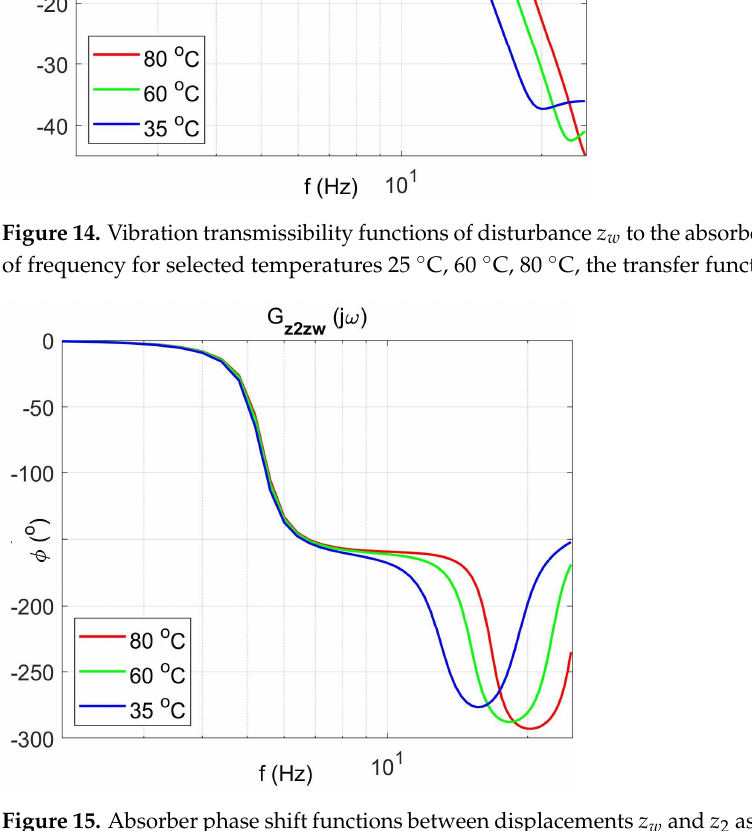
Figure 15. Absorber phase shift functions between displacements z w and z 2 as a function of frequency for selected temperatures 25 ◦ C, 60 ◦ C, 80 ◦ C, the transfer function G z 2 zw